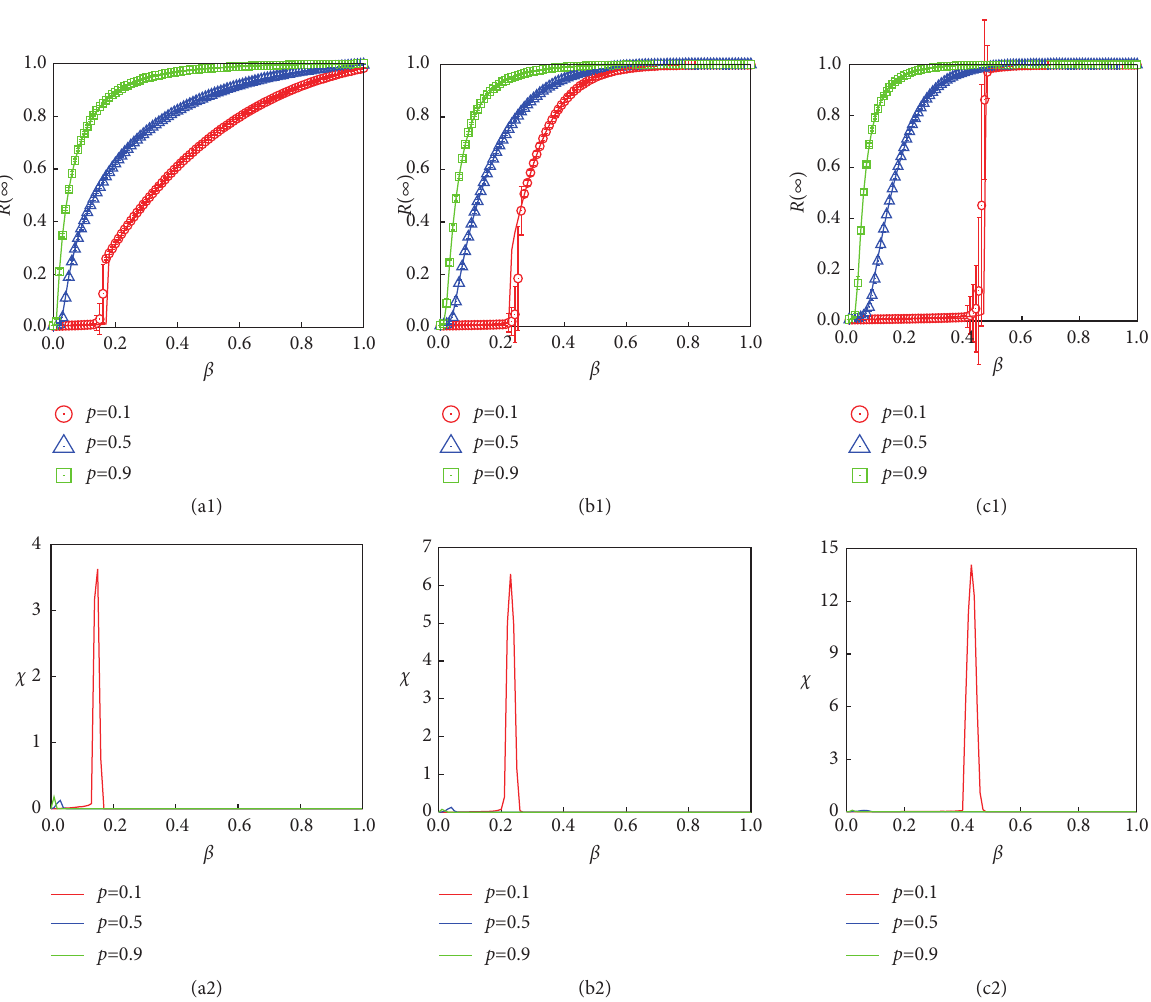
� 0 . 005, T � 1, and T � 3. p q 0